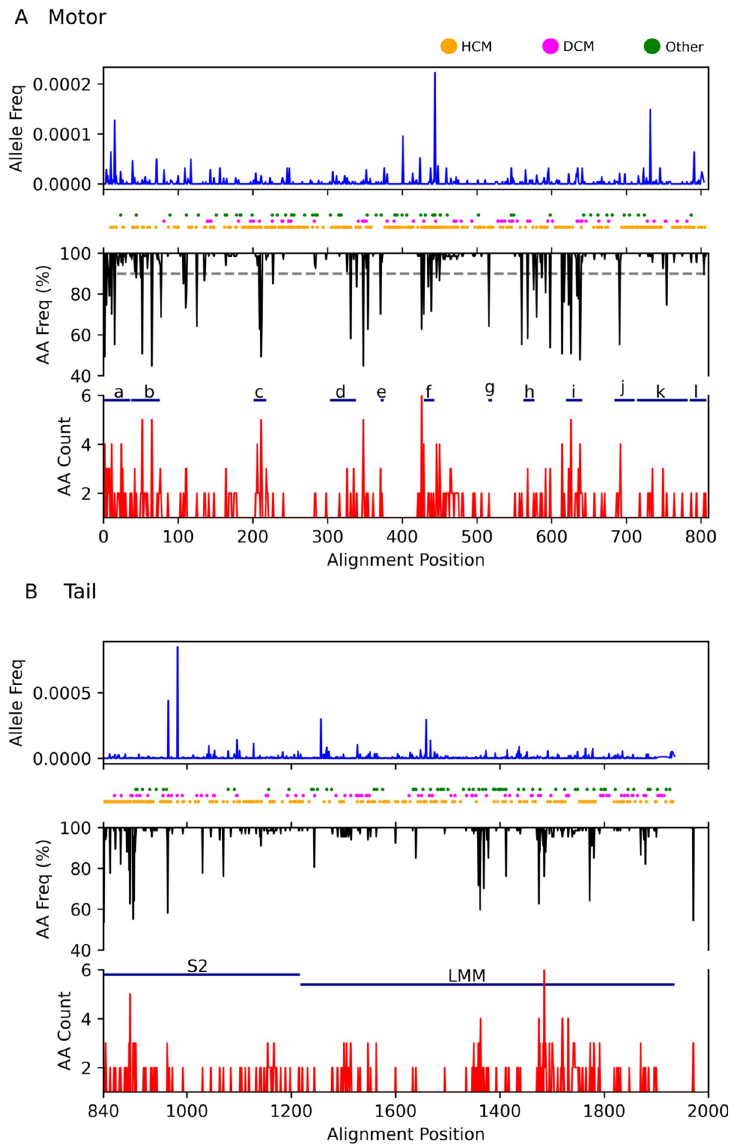
Fig 3. Location of human variation, cardiomyopathy-associated variants, and non-conserved residues for the β isoform. Blue lines show the frequency of missense variation present in the gnomAD. Circles indicate the residue position of variants associated with cardiomyopathy (HCMs in orange, DCMs in magenta, and other in green [14]). Black lines show the frequency with which the consensus amino acid occurs at each residue position in the sequence. Red lines show the number of different amino acids occurring at that position in the sequence (minimum 1). The dashed grey lines indicate the position at which more than 10% of sequences contain an alternate amino acid. Key functional areas of the sequence as listed Motor domain: a. N-terminus 1–36, b. SH3 domain 37–75, c. Loop 1 201– 215, d. Drosophila exon 7 region 300–335, e. Loop 4 368–372, f. Helix-O 426–440, g. Relay helix/loop, h. Loop 3